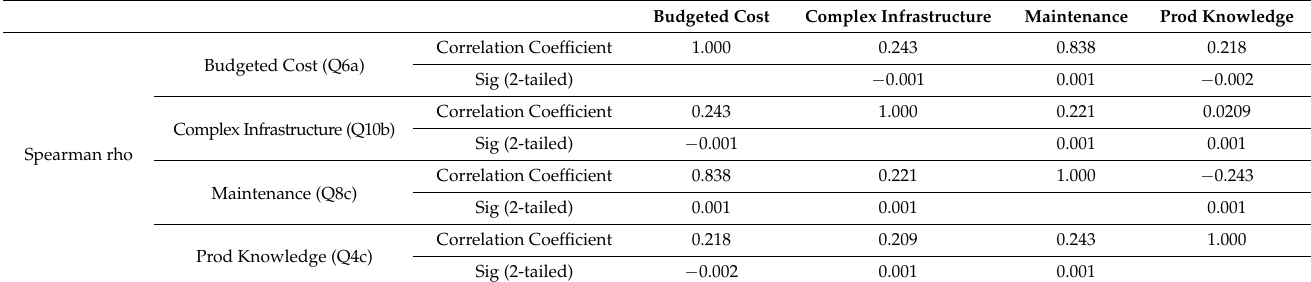
Table 5. Independent Variable Bivariate Spearman